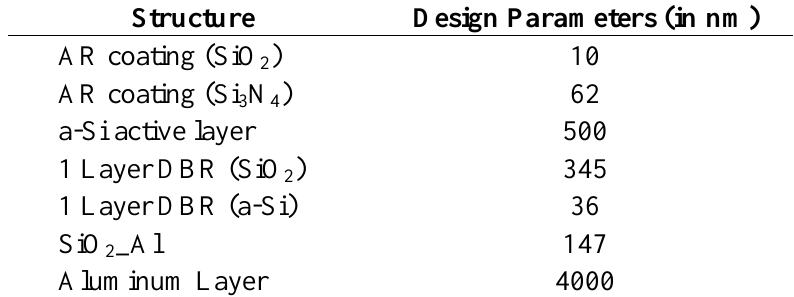
Figure 11. Design schematic of the structure that was fabricated. The structure incorporates an AR coating, a 1Layer (1 period) DBR, a SiO (SiO _Al) and an aluminum layer, all deposited on a glass 2